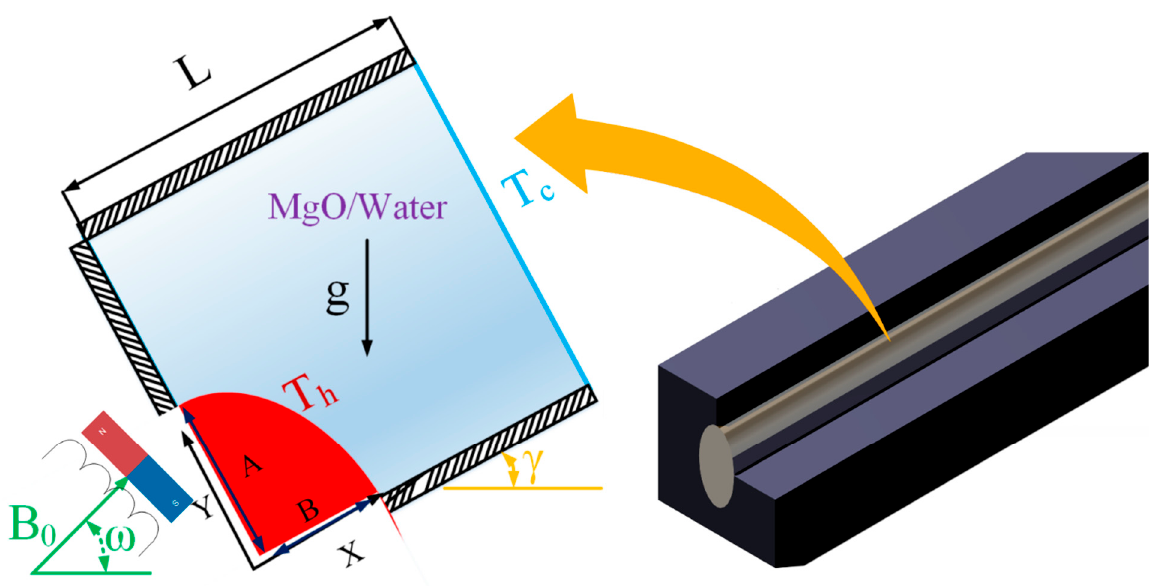
Figure 1. General schematic of the